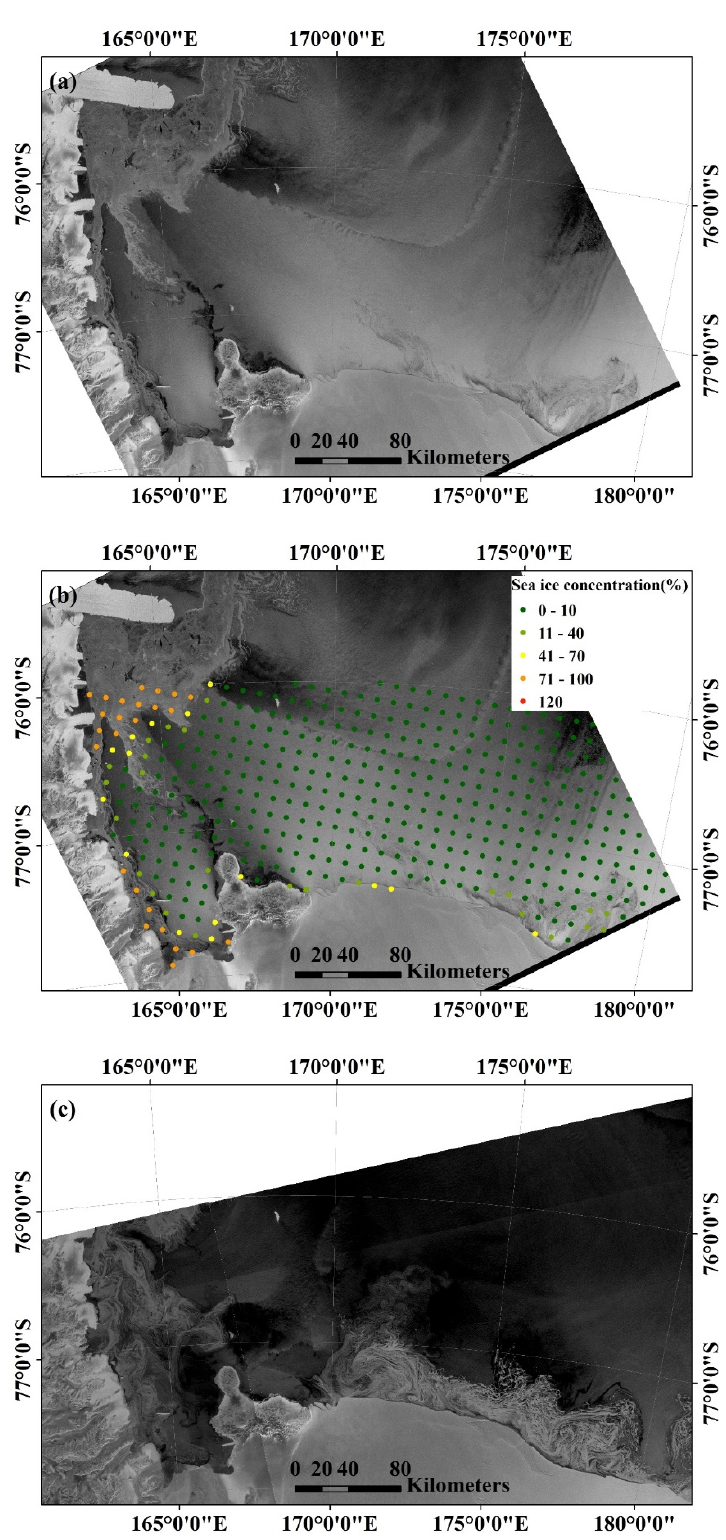
Figure 4. Sentinel-1 images (backscatter) of Ross Sea on 3–4 March 2017: ( a ) backscatter image on 3 March showing bright and homogeneous wind-driven roughness, ( b ) less than 10% ice concentration (from AMSR2) on the bright and homogeneous wind-driven roughness (3 March), and ( c ) disappearance of wind-driven roughness after the wind event on 4 March.